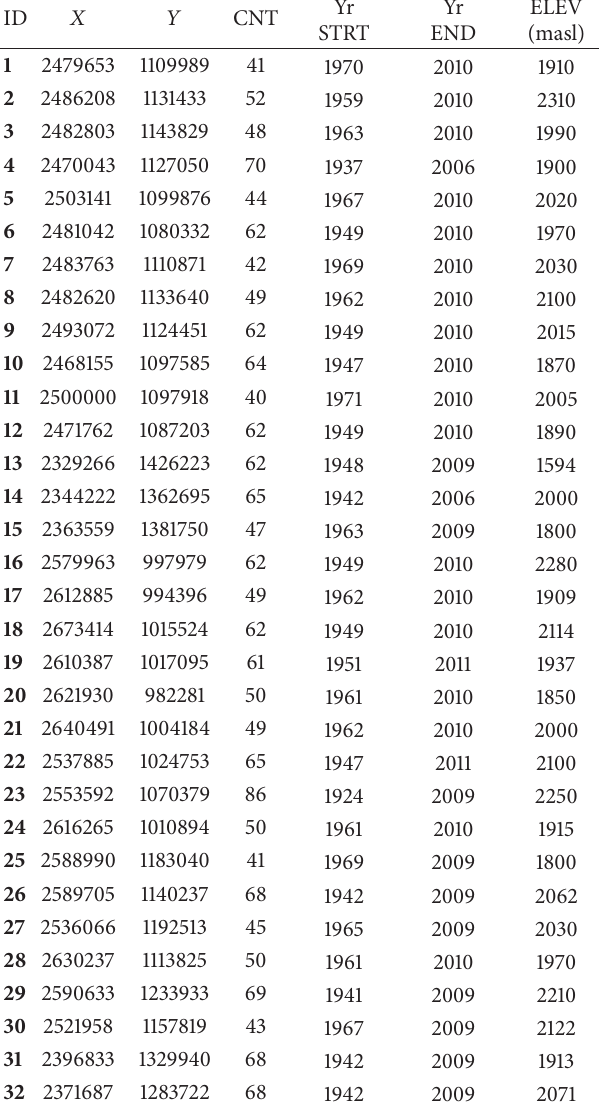
Table 1: Metadata of 32 ground-weather